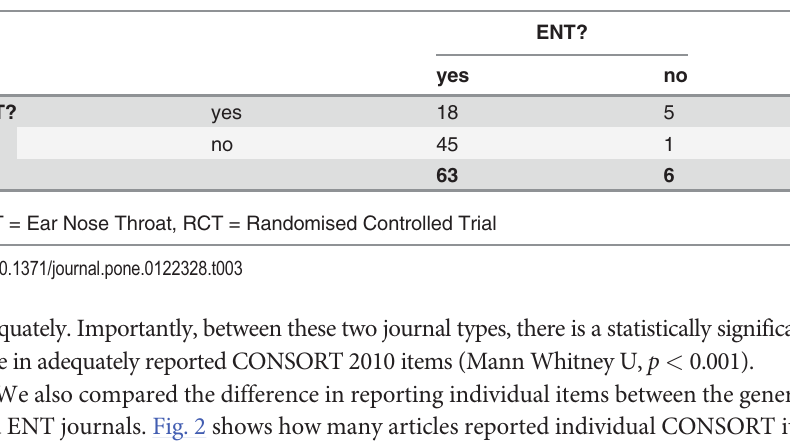
Table 3. Assessment of retrieved articles in ENT journals.